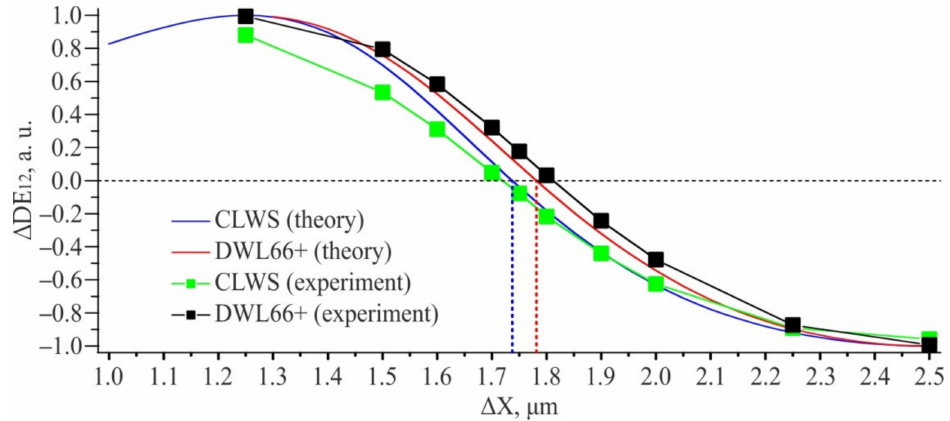
Figure 18. The ratios of the DE difference for diffraction orders (1; 0) and (2; 0) to their sum.